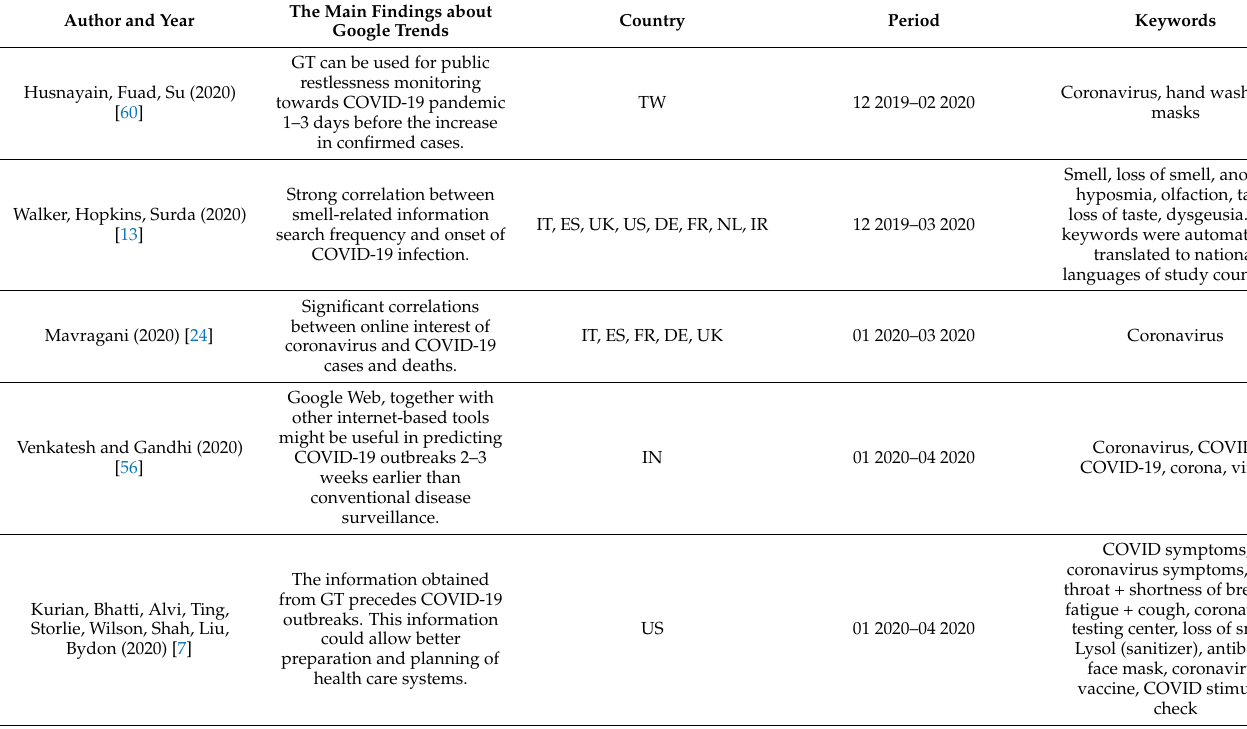
Table 1. Publications with positive results of GT use for COVID-19 prediction and